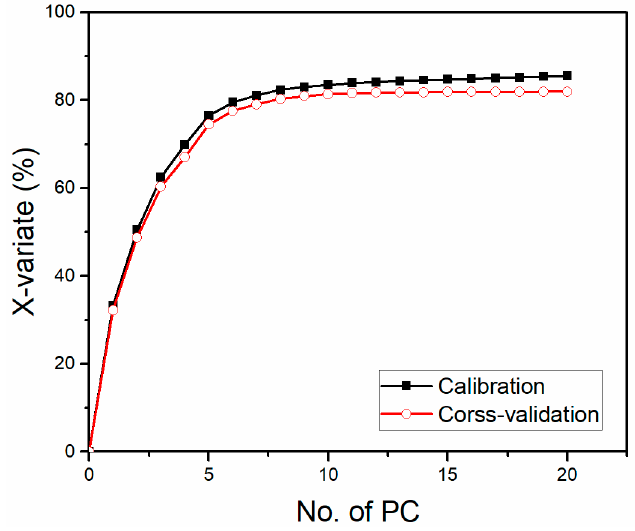
Figure 8. Explanation of the X-variate for Figure 8. E x planation of the X-variate for PCA.